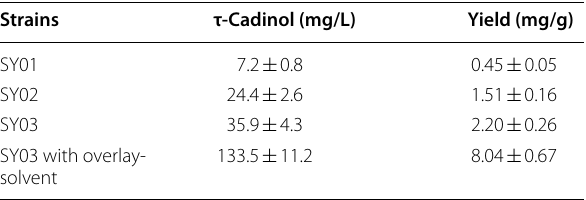
Table 3 τ-Cadinol production in engineered E. coli strains